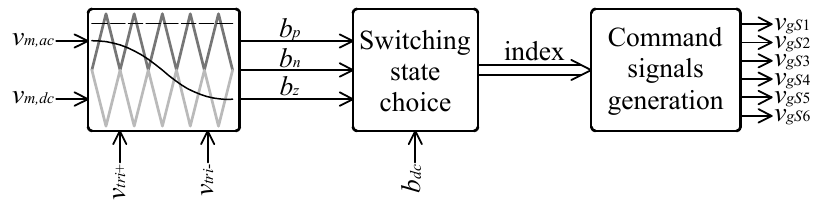
Figure 6. Modulation block diagram